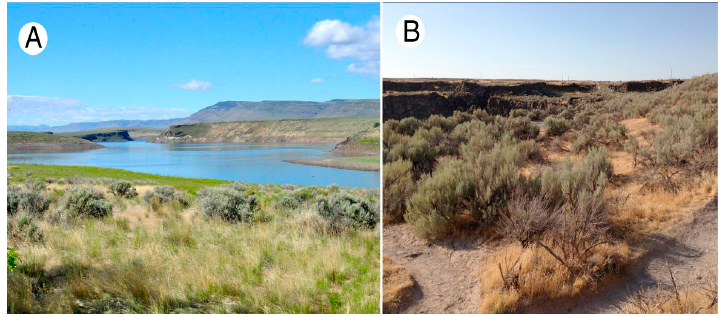
Figure 3. Modern views of the Snake River Plain, near Salmon Falls ( A ) and Shoshone Falls ( B ); Idaho USA.